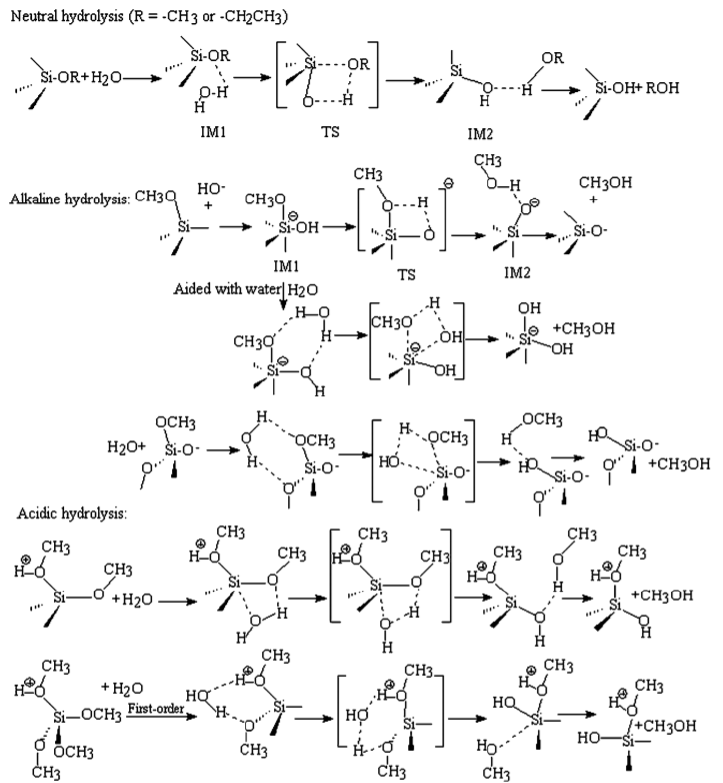
Figure 2. A schematic drawing of the hydrolysis mechanisms in different media. TS = transition state, IM = intermediate. Reprinted with permission from [35]. Copyright John Wiley and Sons, 2012.